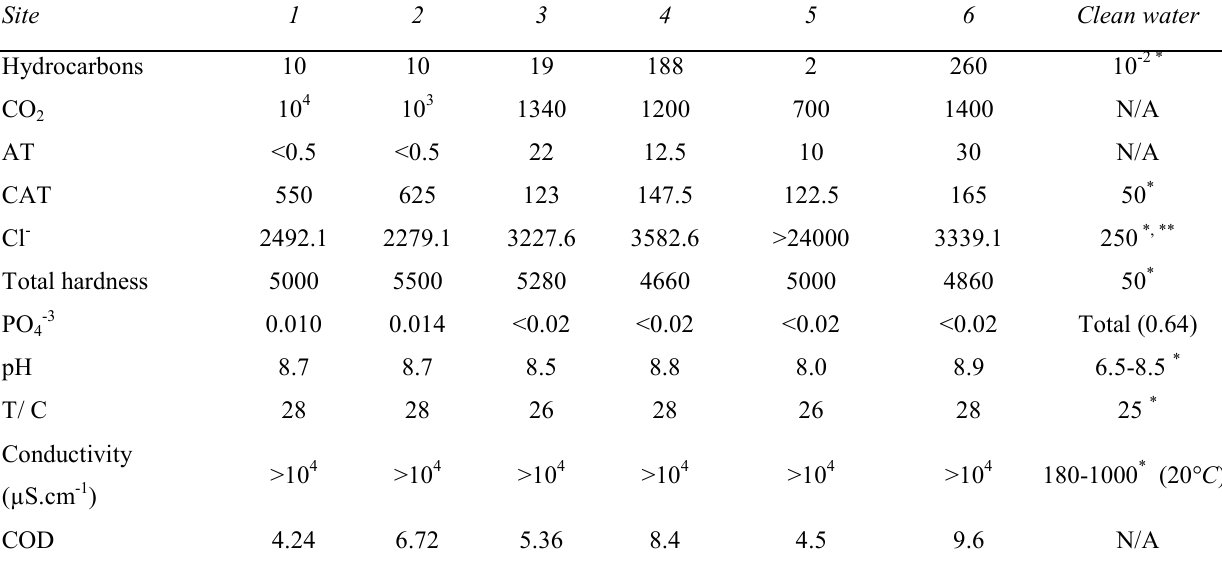
Table 1: Different chemical constituents expressed in ppm and corresponding to six different sampling points.